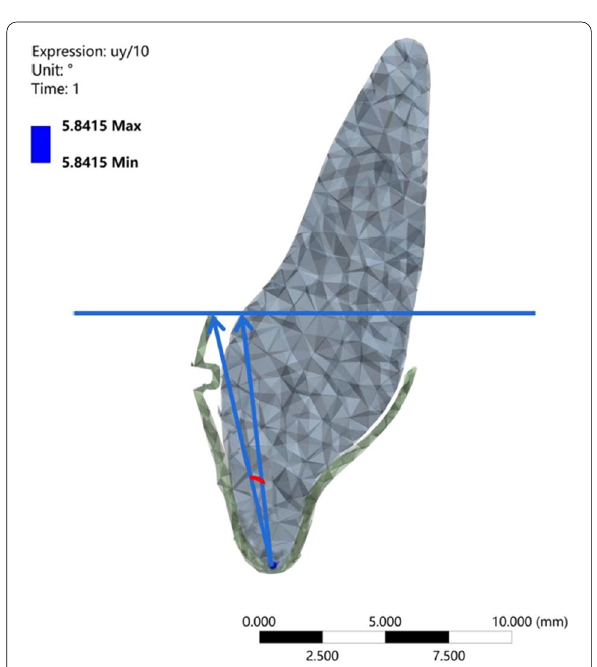
Fig. 9 The angle of distortion between the inner surface of the aligner and the tooth surface generated by the power